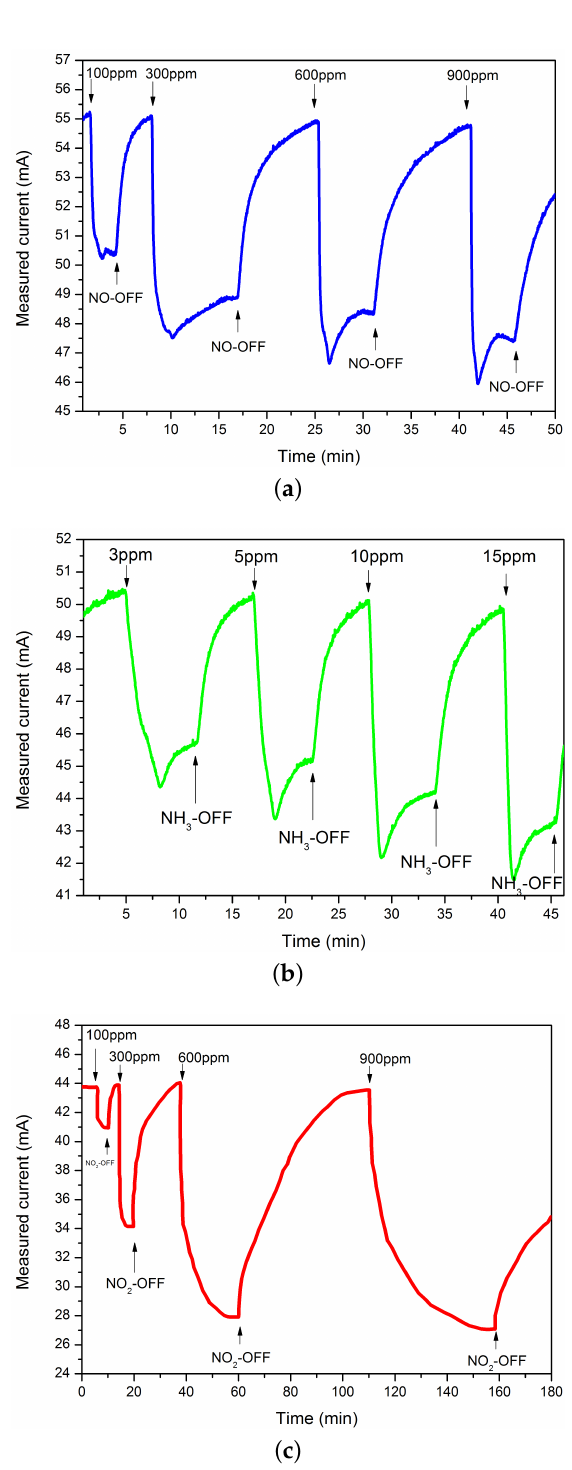
Figure 4. Response of the Pt-AlGaN/GaN HEMT sensor to ( a ) NO; ( b ) NH 3 ; and ( c ) NO 2 gases for different concentrations using sensors with a gate size of 2 µm × 150